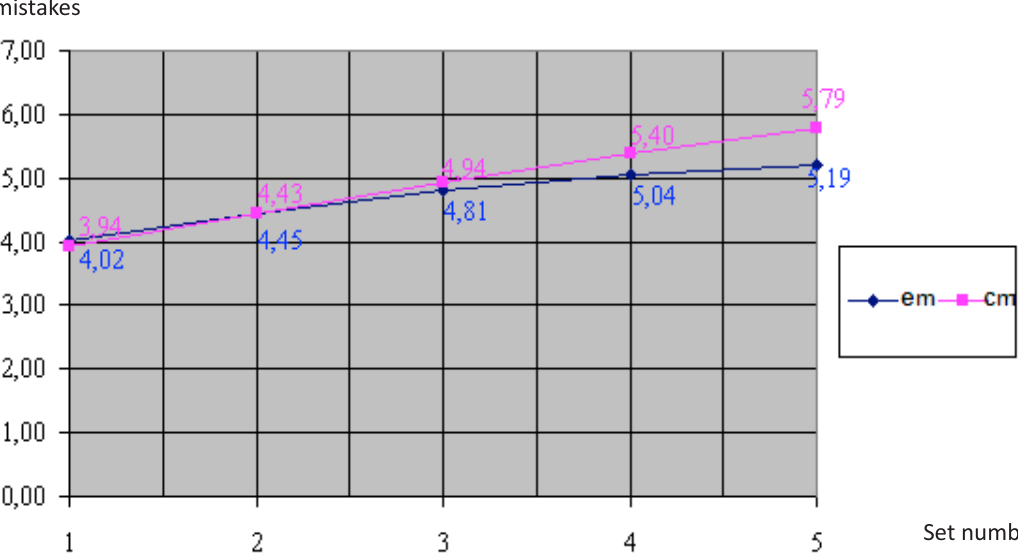
Fig. 3. Comparative analysis of experimental and control groups ping pong data for October, where е group data for October, c –control group data for October, 1 – 5 set numbers, 0 – 8.00 - quantity of made o